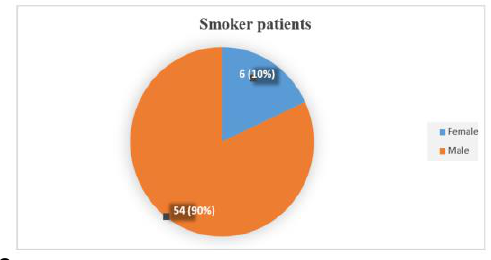
Fig. 2. Frequency of smokers regarding sex factor